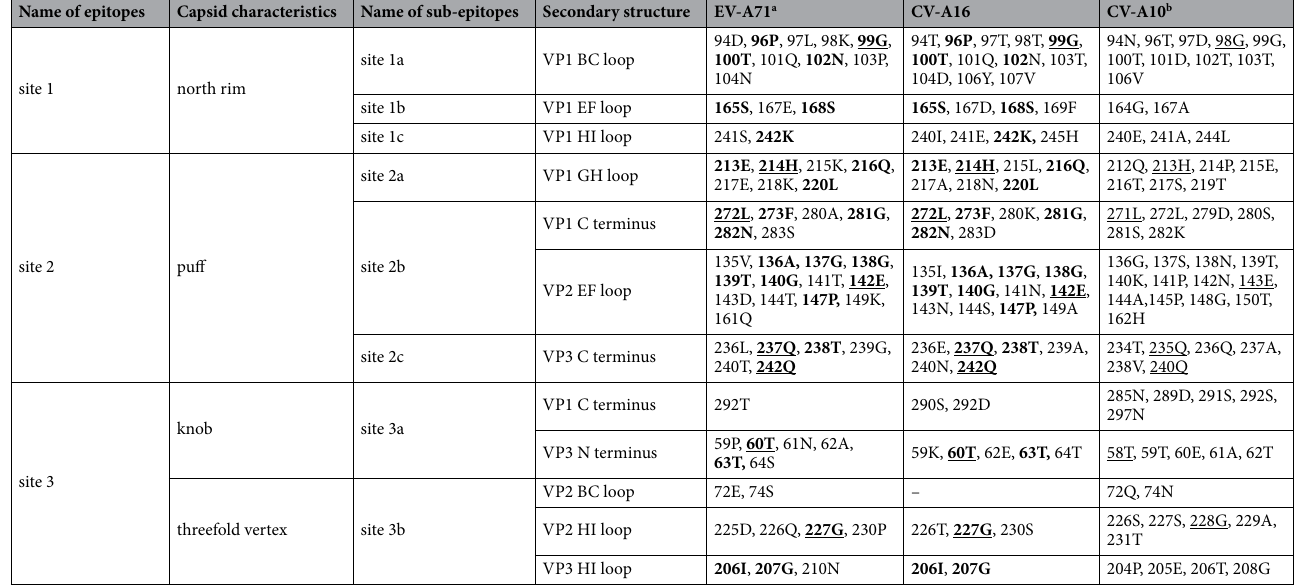
Table 1. Prediction results of conformational epitopes of EV-A71, CV-A16 and CV-A10. a The bold letters represent the conserved amino acids between EV-A71 and CV-A16. The underlines represent the conserved amino acids among EV-A71, CV-A16 and CV-A10. b The prediction results of conformational epitopes of CV-A10 are from our previous study with the permission of the journal 44